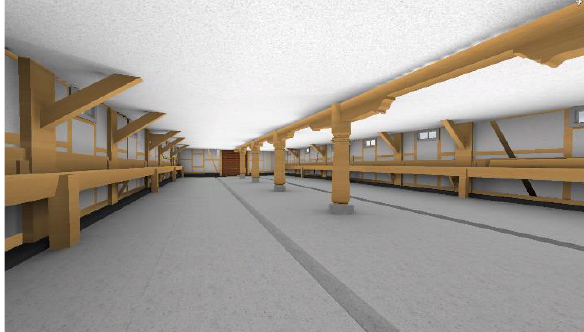
Figure 8 . BIM model of the ground level of the building with custom wooden structures.